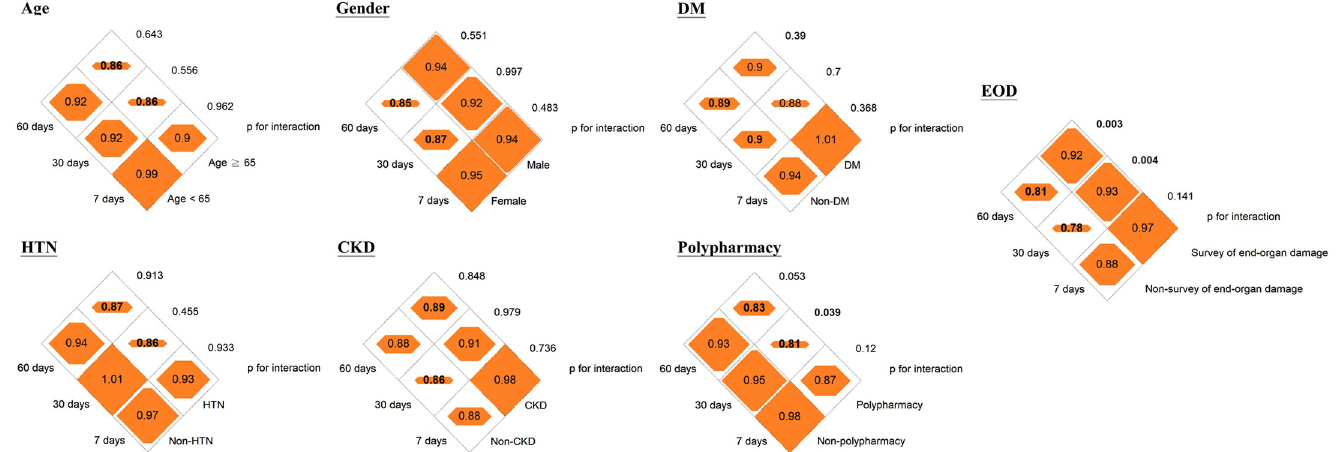
Fig 2. Diamond graphs summarize the adjusted hazard ratios (HRs) of 7-day, 30-day, and 60-day ED revisit or inpatient admission by clinical characteristics of the study population. DM, diabetes; HTN, hypertension; CKD, chronic kidney disease; EOD, end-organ damage. Numbers in the orange diamonds stand for the adjusted HRs, where the bold numbers represent the 95% confidence interval not overlapping with null value 1.0. Detailed information is provided in the S3A Table.